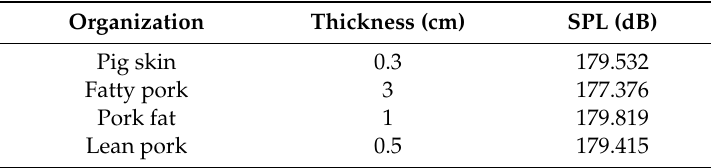
Figure 13. The test device of the penetration performance of ultrasound. Table 3. Ultrasonic signals measured under different pork tissues.